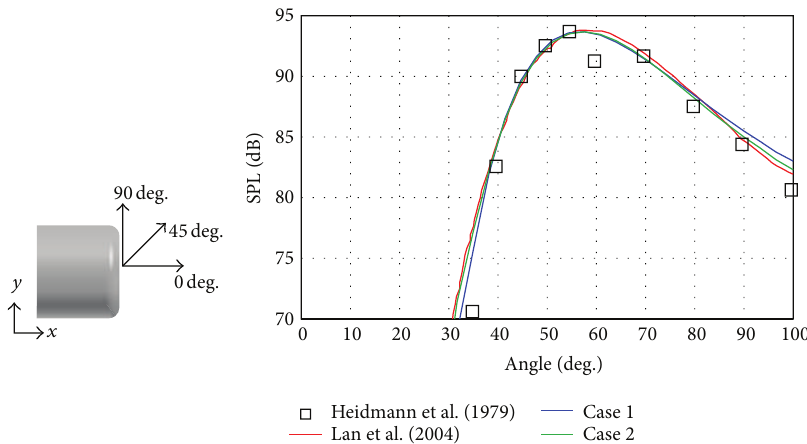
Figure 13: The sound pressure level (SPL) distributions at a radius of 𝑟 = 49 D